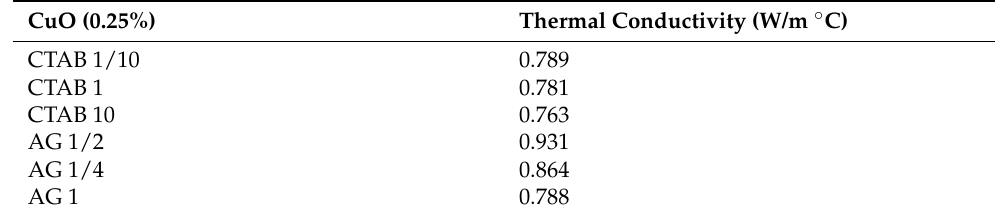
Table 1. Thermal conductivity of used nanofluid using different concentrations of surfactant. CuO